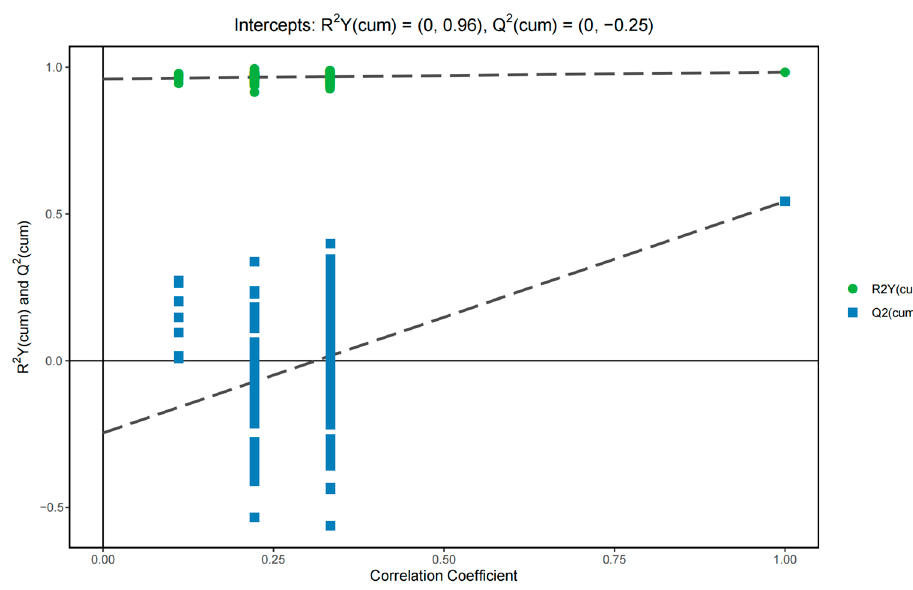
Figure 3. Permutation test results of the OPLS-DA model of the sixth accumulative temperate zone against other accumulative temperate zones.